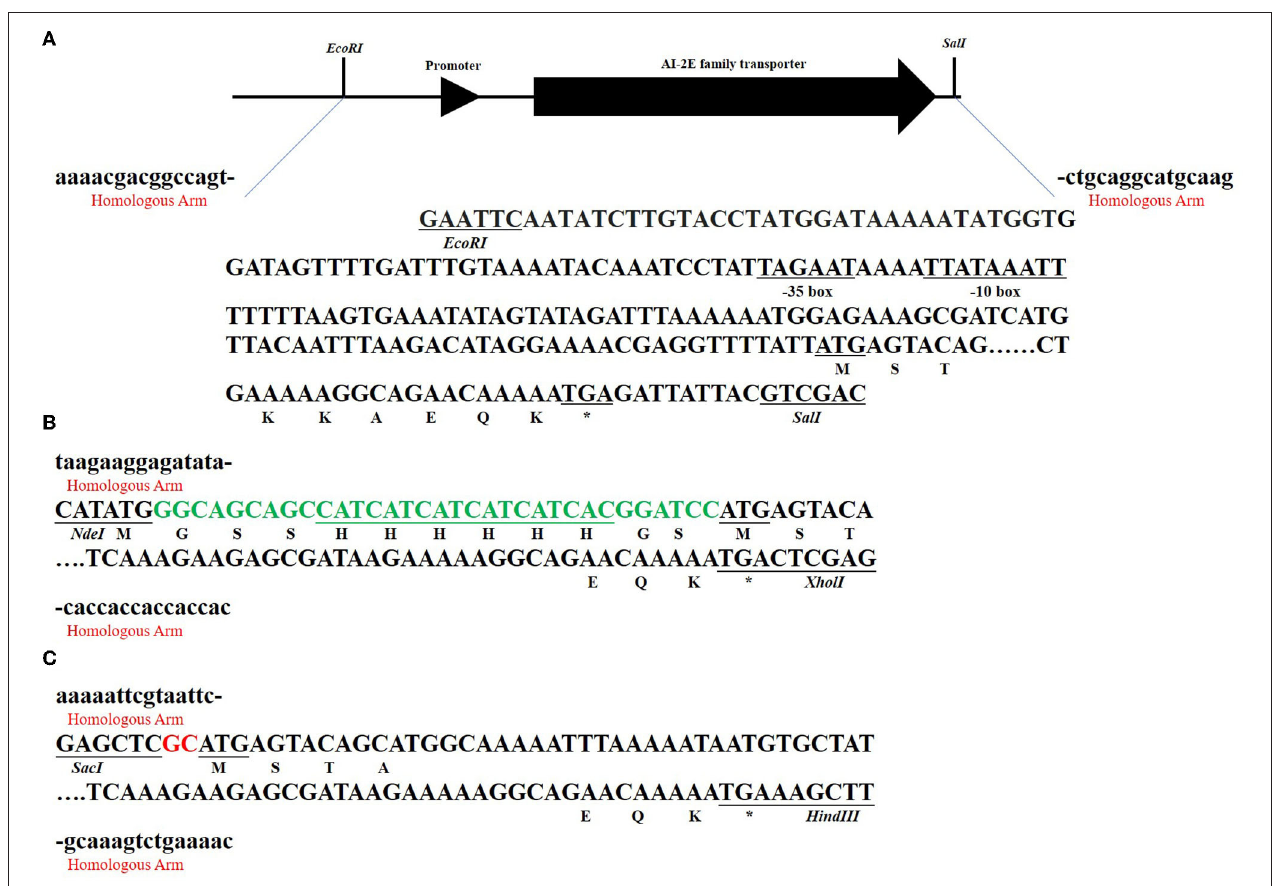
FIGURE 3 | The subcloning strategy of the AI-2E gene. The sequences marked with red “homologous arm” represent the homologous arm when ligated to the vector, and the marked restriction endonucleases represent the two enzymes used in linearizing the vector. The asterisks represent the termination codon. The subcloning strategy of AI-2E gene and its promoter DNA fragment that for ligation to pUC19 vector (A) . The subcloning strategy of AI-2E gene that for ligation to pET22b vector (B) . Subcloning strategy for the AI-2E gene used to ligate to the pMG36e vector to construct an overexpression vector (C)